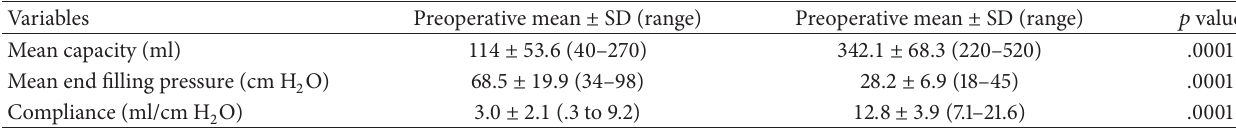
Table 6: Pre- and postoperative urodynamic parameters.